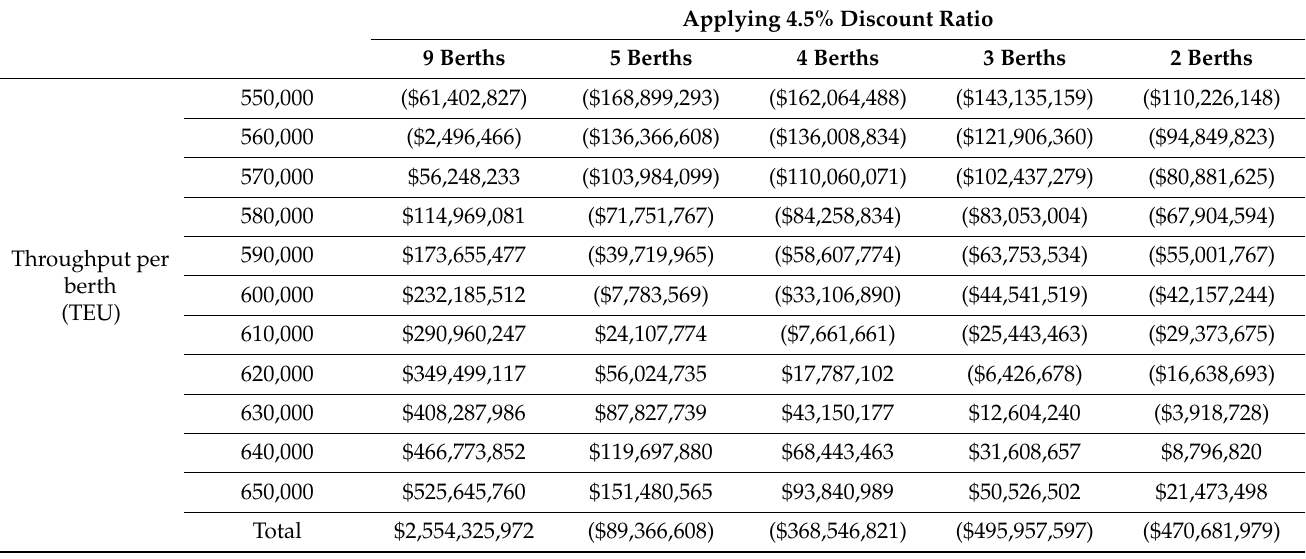
Table 6. Net present value (NPV) per berth considering changes of the unloading volume (unit: U.S. dollars). Applying 4.5% Discount Ratio 9 Berths 5 Berths 4 Berths 3 Berths 2 Berths